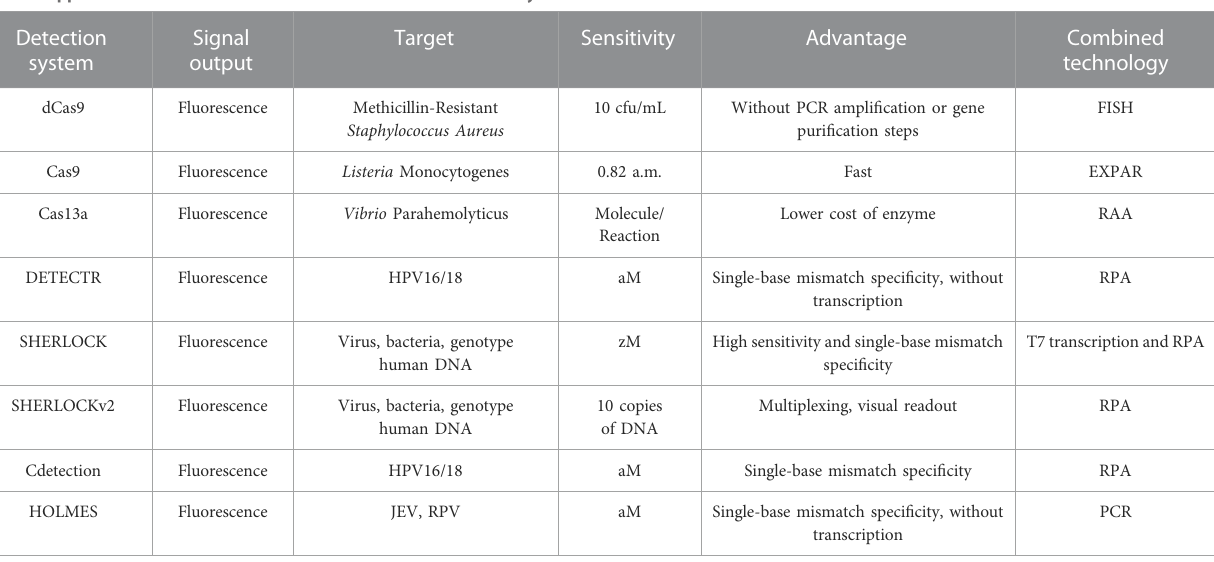
TABLE 2 Applications of nucleic acid detection based on CRISPR-Cas